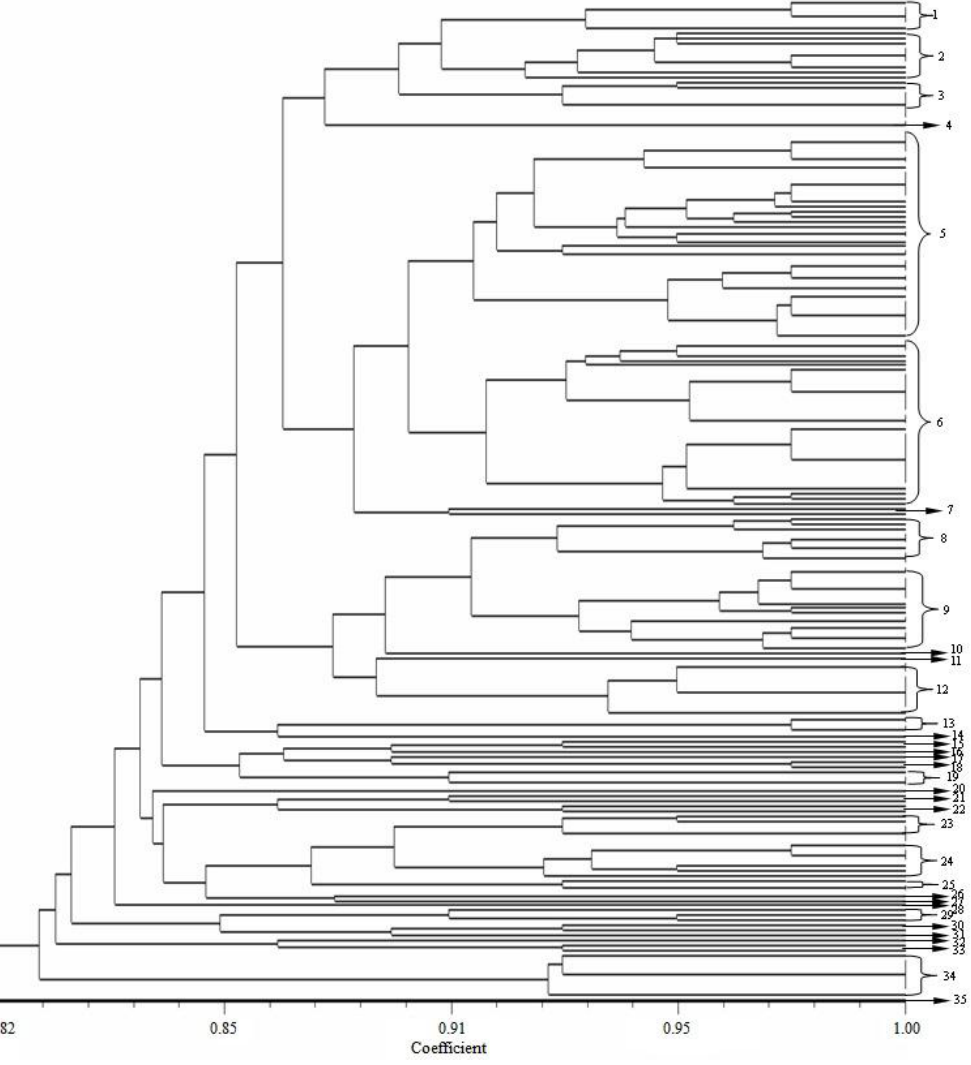
Figure 3. Dendrogram showing the relationship of 267 antagonistic bacteria based on BOXAIR-PCR fingerprints using cluster